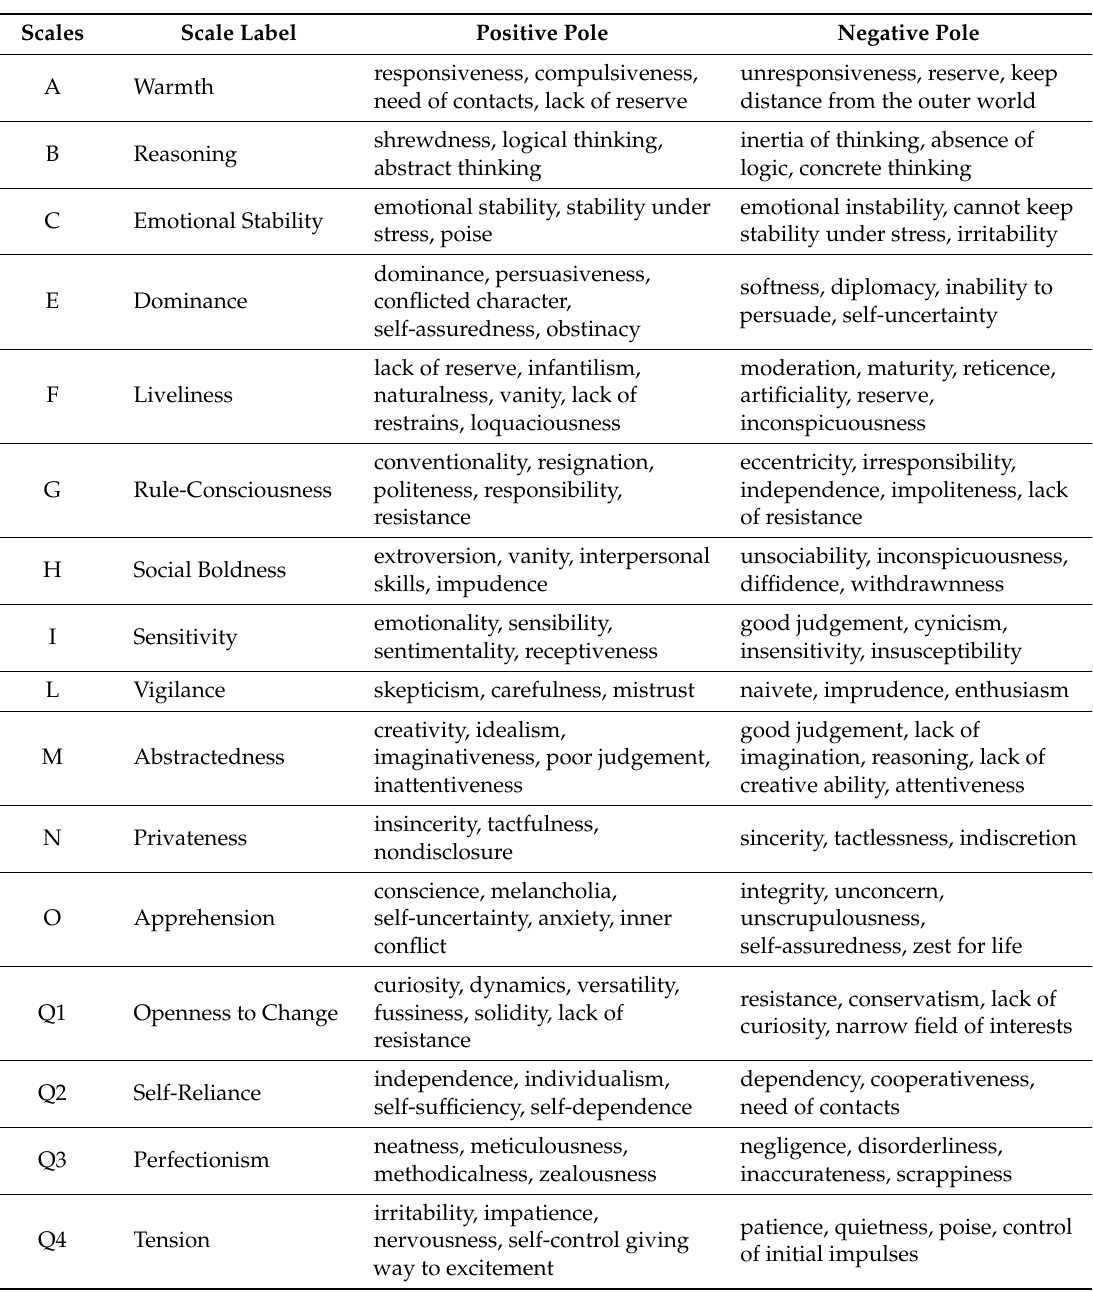
Table 3. Scale modelling of the 16 Personality Factor Questionnaire Revised (16PF-R) with handwriting